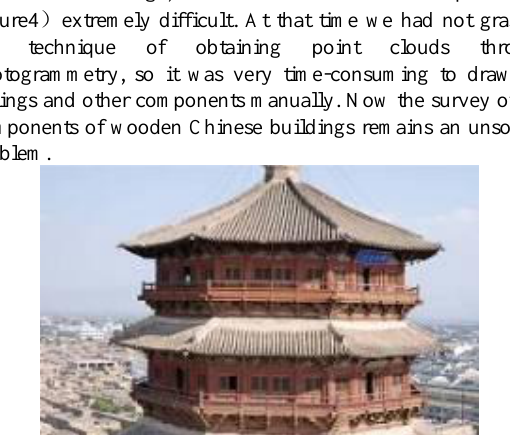
Figure4: Façade of Pagoda (aerial image by unmanned helicopter )